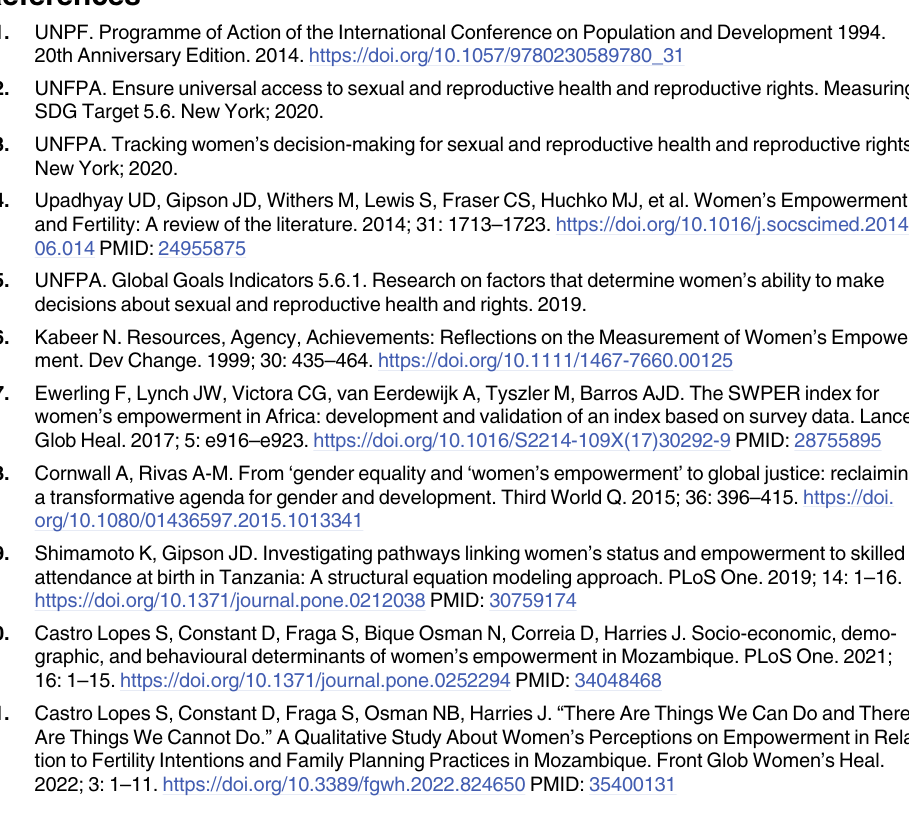
S2 Table. A: Crude and adjusted odds ratio (95% CI) from the multinomial logistic regression to estimate the association between the empowerment domains and fertility-related outcomes; and B: Crude and adjusted odds ratio (95% CI) from the multinomial logistic regression to estimate the association between the empowerment domains and contraceptive practices. S1 Fig. Scree plot of eigenvalues after